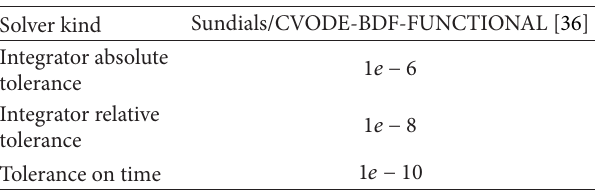
Table 1: Solver parameter for time